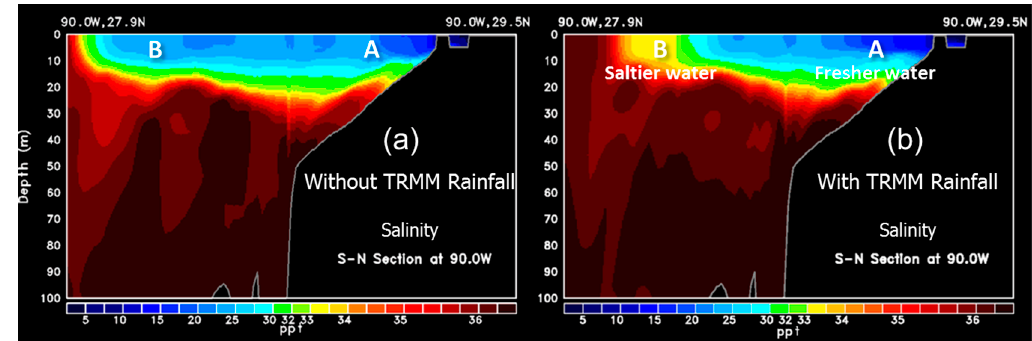
Figure 8. Effect of including satellite TRMM rainfall on salinity. Salinity north-south cross-section (right to left) at 90°W for May 2008 for ( a ) reference run (monthly climatology surface salinity flux); and for ( b ) test run (salinity flux estimated with TRMM rainfall).